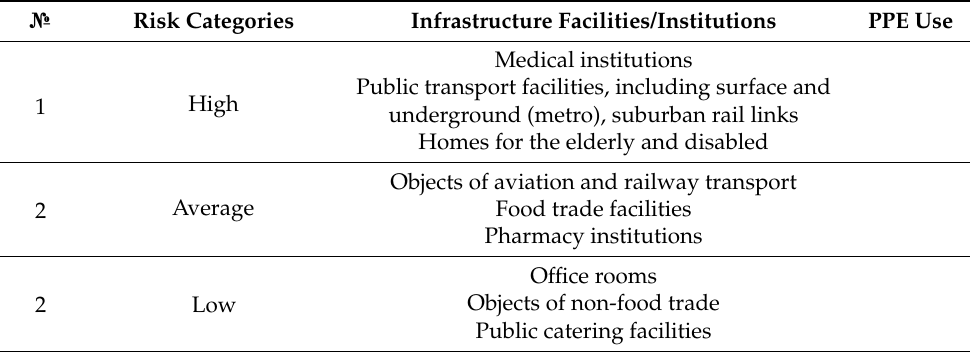
Table 3. Classification of activities (professions) by risk of infection with COVID-19 (recipients of COVID-19).